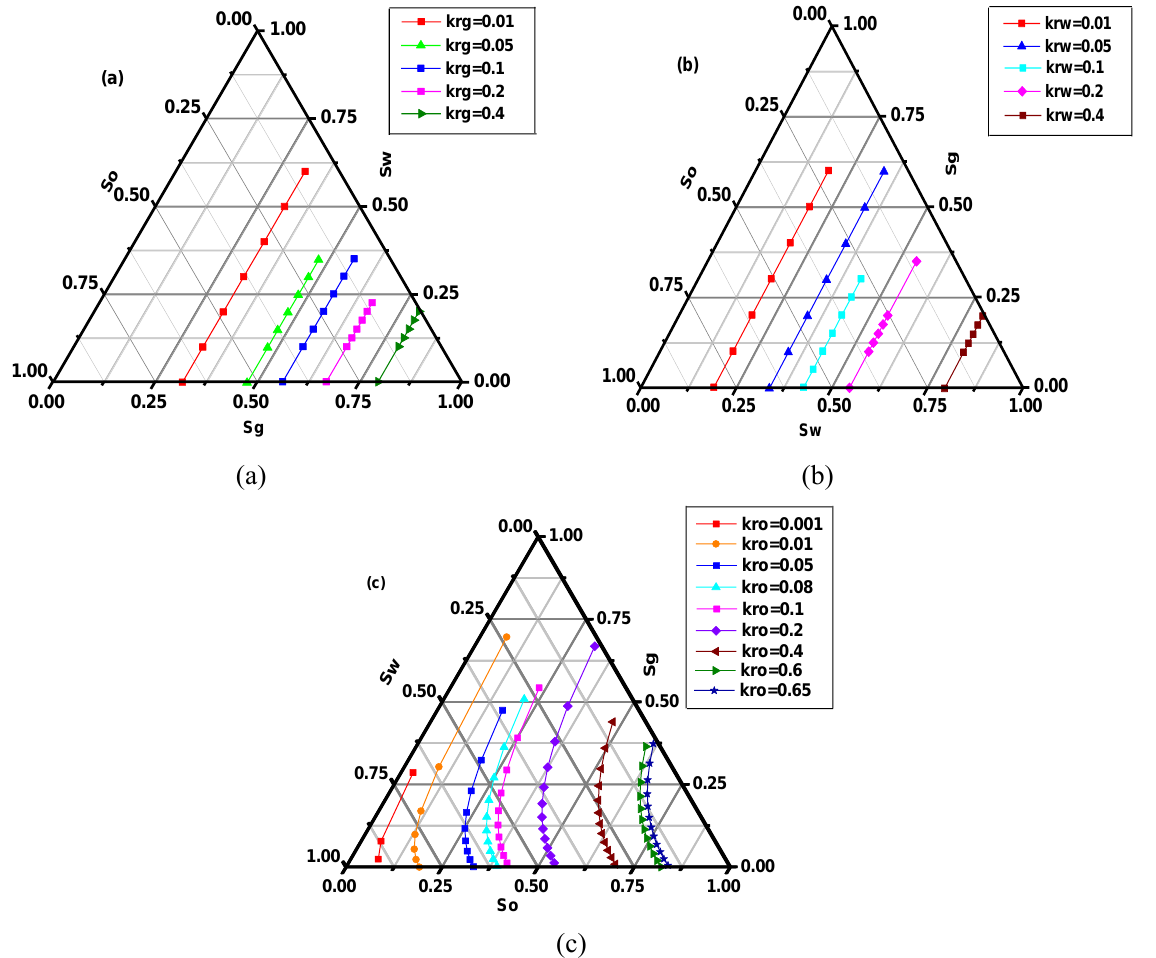
Figure 2—The isoperms of different phase for fracture systems calculated for the Example. (a) Gas phase. (b) Water phase. (c) Oil phase.